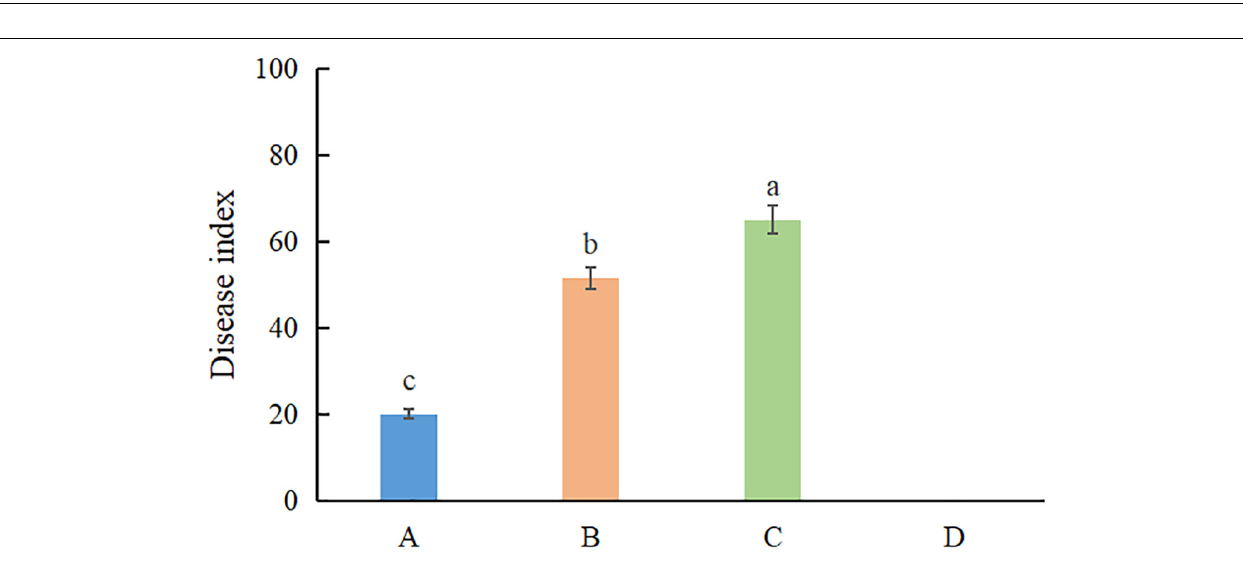
can alter the disease responses in different host